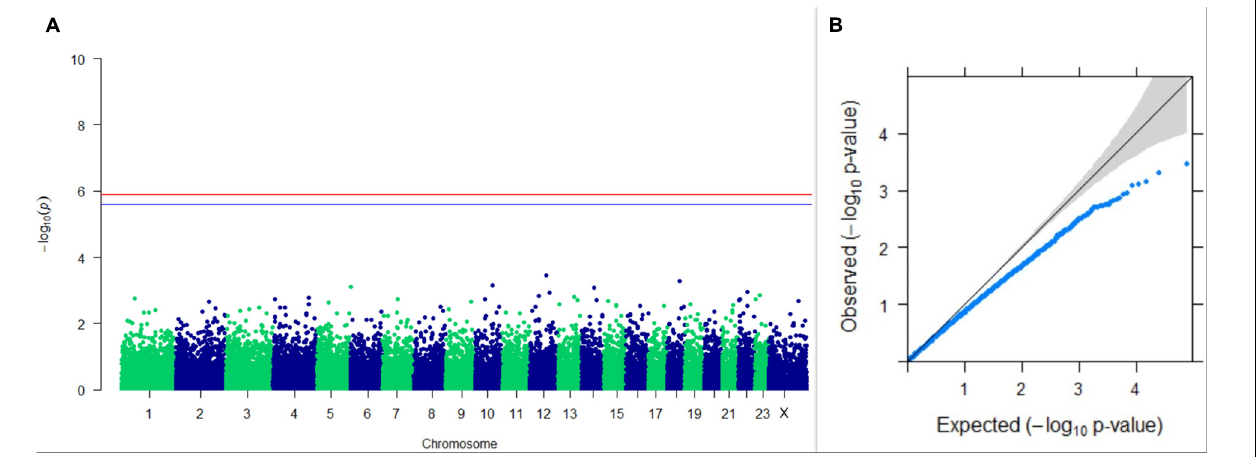
FIGURE 11 | Results of GWAS for lactation persistency according to Mahadevan. (A) Manhattan plot of genome-wide SNPs. The red line indicates the p- value threshold (expressed as –log 10 P ) corresponding to FDR-corrected p- values or q = 0.05, above which the SNPs are considered to be significantly associated with the trait, while the blue line indicates the genome-wide suggestive threshold at q = 0.1. The SNPs identified on chromosome no. 24 were screened out from analysis because of stringent quality control; hence, it is not represented in the Manhattan plot. (B) Q-Q plot of the p- values.